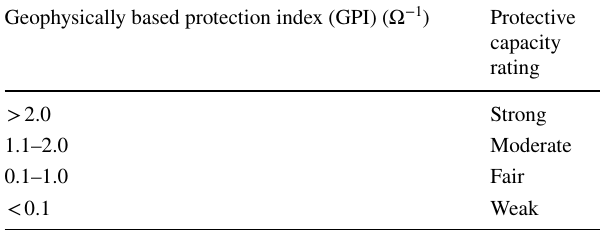
Table 1 Rating of protective capacity based on GPI (Casas et